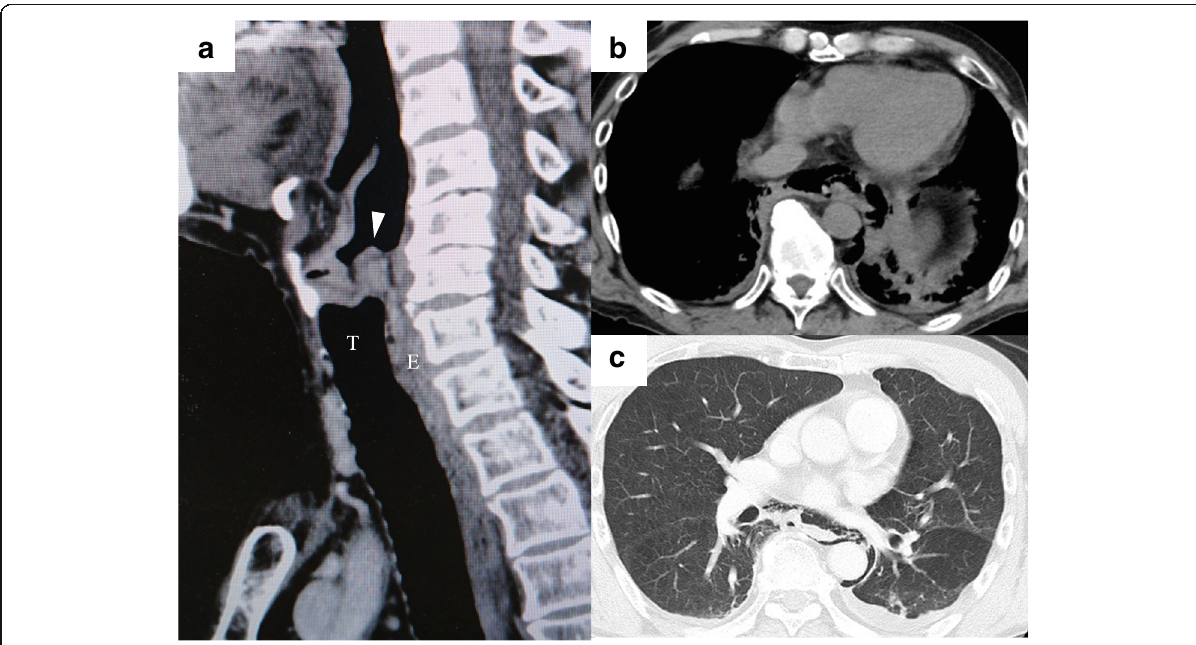
Fig. 1 a Enhanced CT on sagittal section demonstrates stenosis caused by hypopharyngeal cancer involving the oropharnx (arrowhead, hypopharyngeal cancer). b , c Enhanced CT demonstrates extensive mediastinal emphysema, which ranged from the neck to the gastric cardia, and a small amount of left pleural